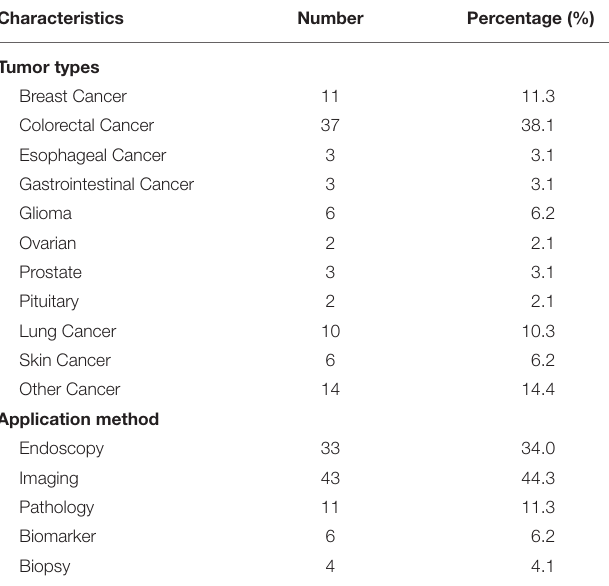
TABLE 4 | Overview of clinical trials in